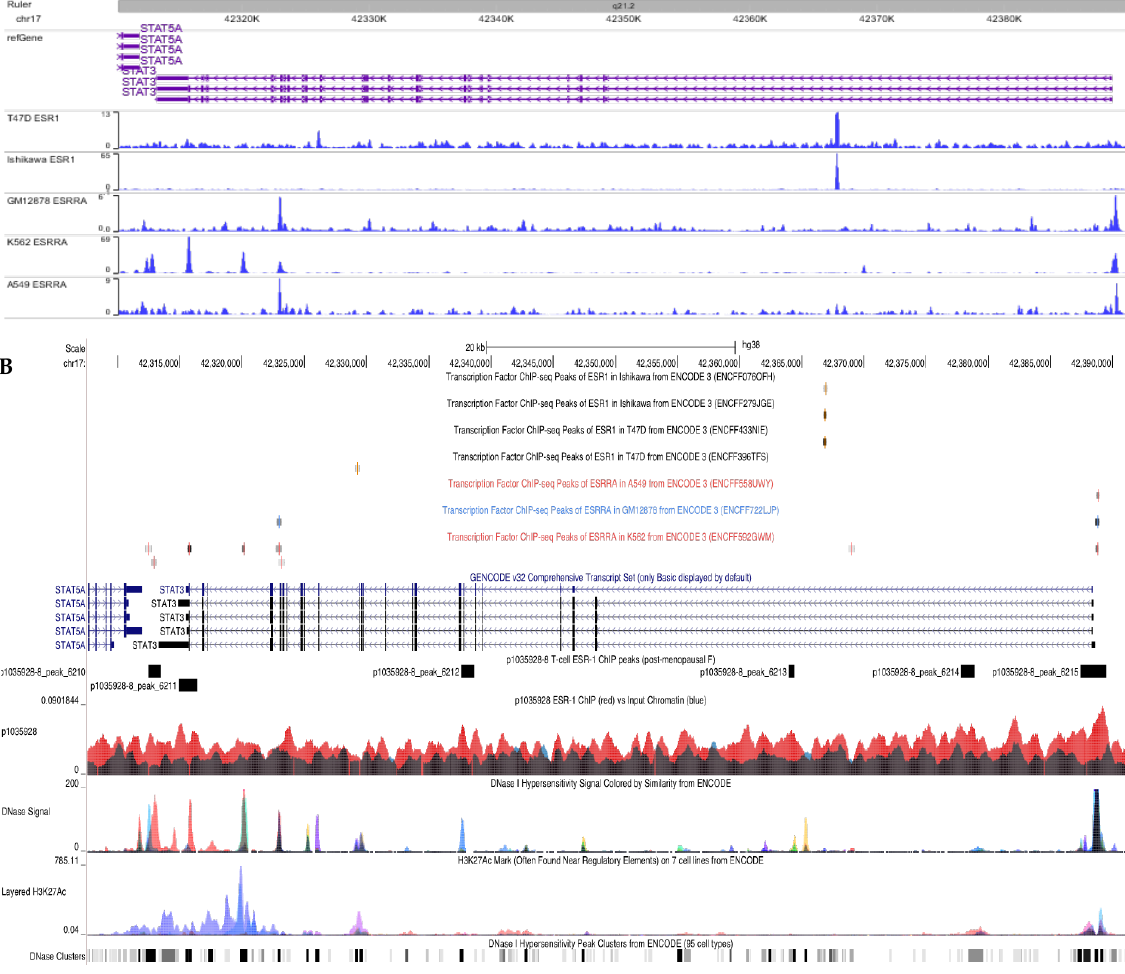
Figure 1. Genomic visualization of ESR1 or ESRRA binding activity at the STAT3 gene locus. ( A ) Gene annotations indicate the position of STAT3, its exons (thick bars) and introns (connecting arrows showing the direction of translation). Blue tracks indicate the enrichment of the ChIP-seq signal for ESR1 or ESRRA binding over the background input for five cell lines. Sharp, prominent peaks provide evidence for the ability of these transcription factors to bind STAT3, demonstrating their interaction in these cell types. ( B ) Track visualization of ER α ChIP-seq for the STAT3 locus. Primary CD4+ T-cell ER α ChIP enrichment signal (red) is depicted against the input chromatin signal (black). Rectangular regions above the ChIP track indicate regions significantly enriched with ER α binding. Top: Additional tracks indicate positions of ESR1 or ESRRA binding activity in ChIP-seq data from the ENCODE project. Note that ER α binding events are not typically shared from experiment to experiment, even when cell lines are identical. Bottom: DNase and H3K27ac signal from the ENCODE project, indicating regions of strong enhancer activity in general cell